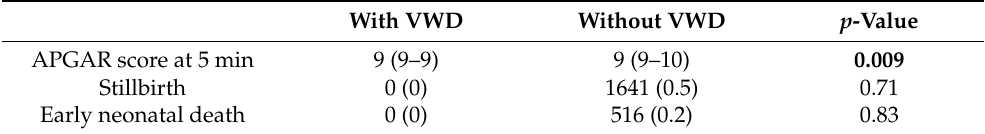
Table 2. Neonatal outcomes of infants born to mothers with von Willebrand disease (VWD) in comparison to mothers without VWD. With VWD Without VWD p -Value APGAR score at 5 min 9 (9–9) 9 (9–10) 0.009 Stillbirth 0 (0) 1641 (0.5) 0.71 Early neonatal death 0 (0) 516 (0.2)